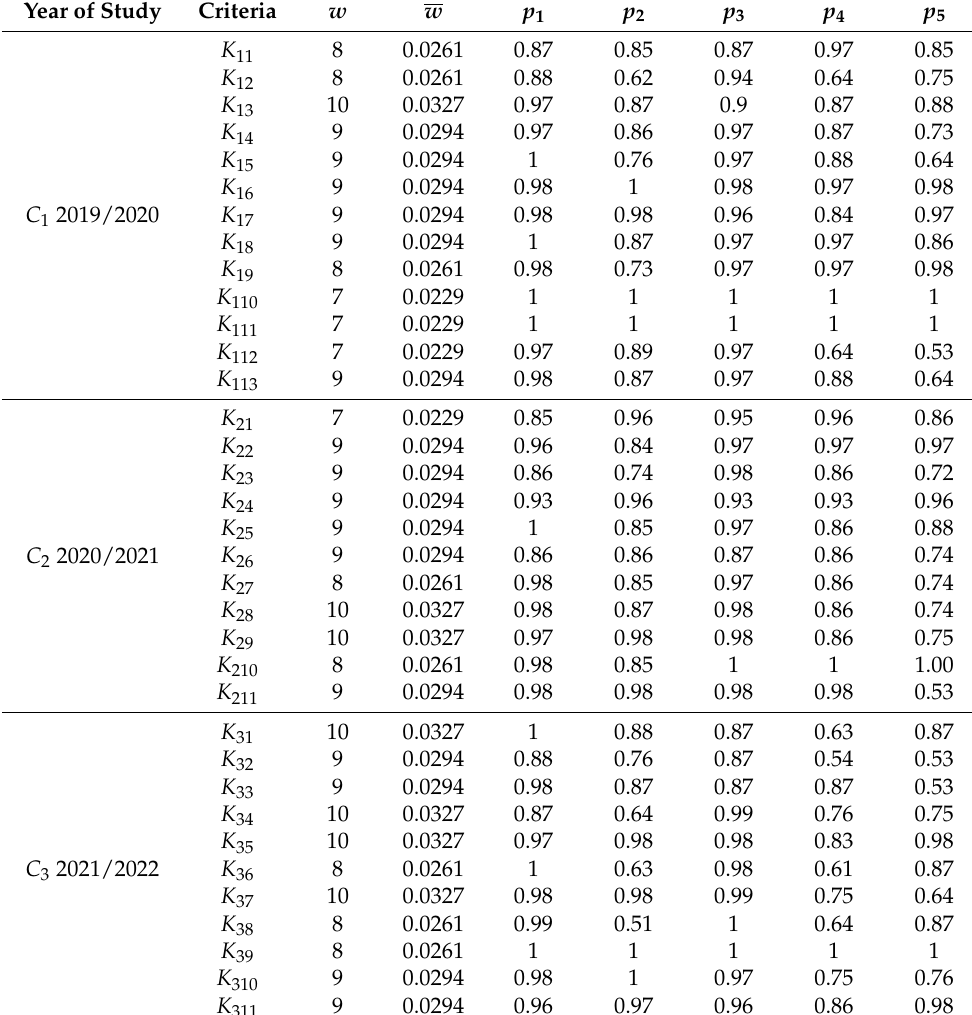
Table 3. Fuzzification of input hybrid